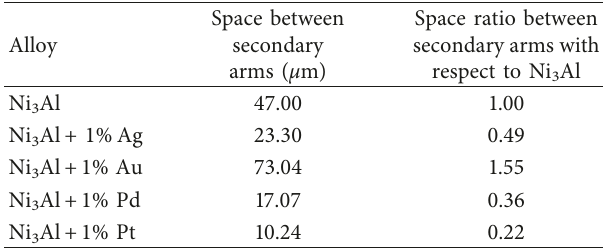
Table 1: Spaces between secondary arms and space ratio, taking as reference the undoped